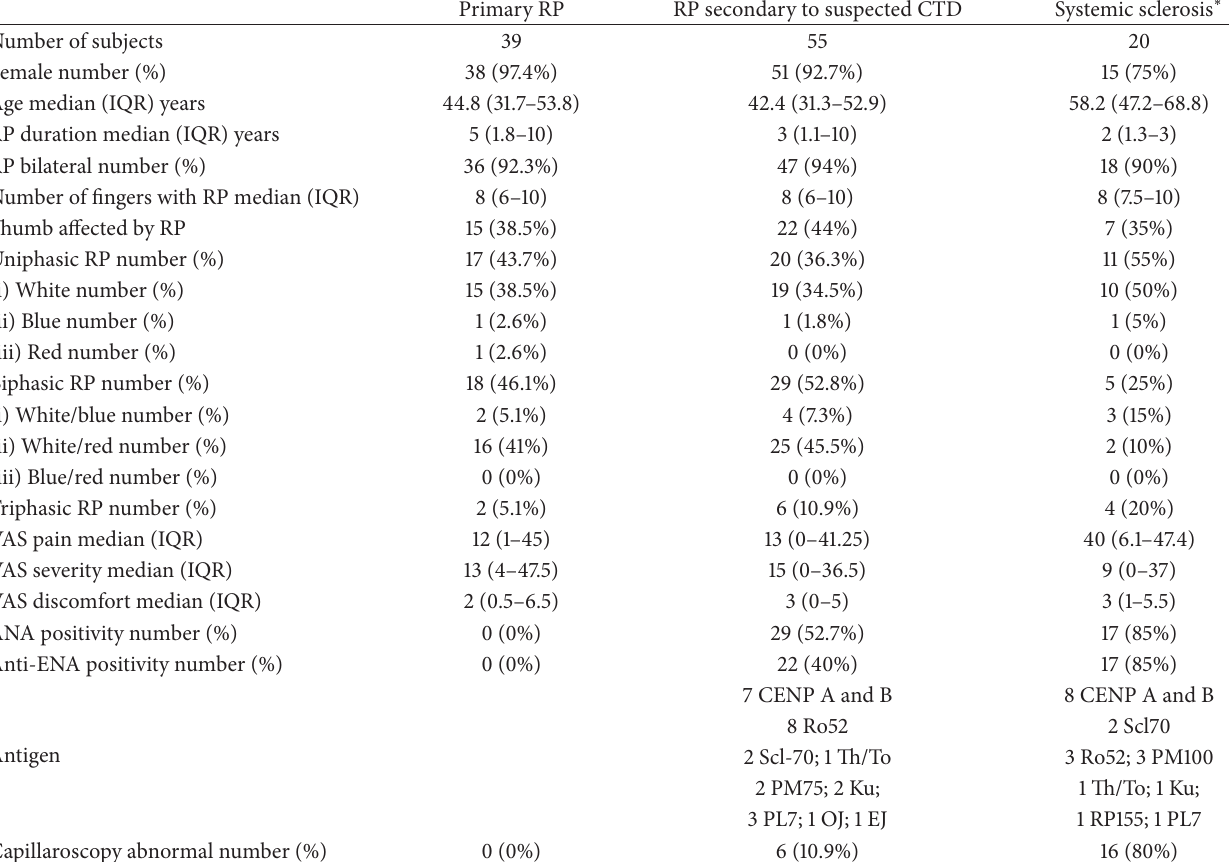
Table 1: Demographic data, clinical features, and diagnostic investigations of the study cohort.